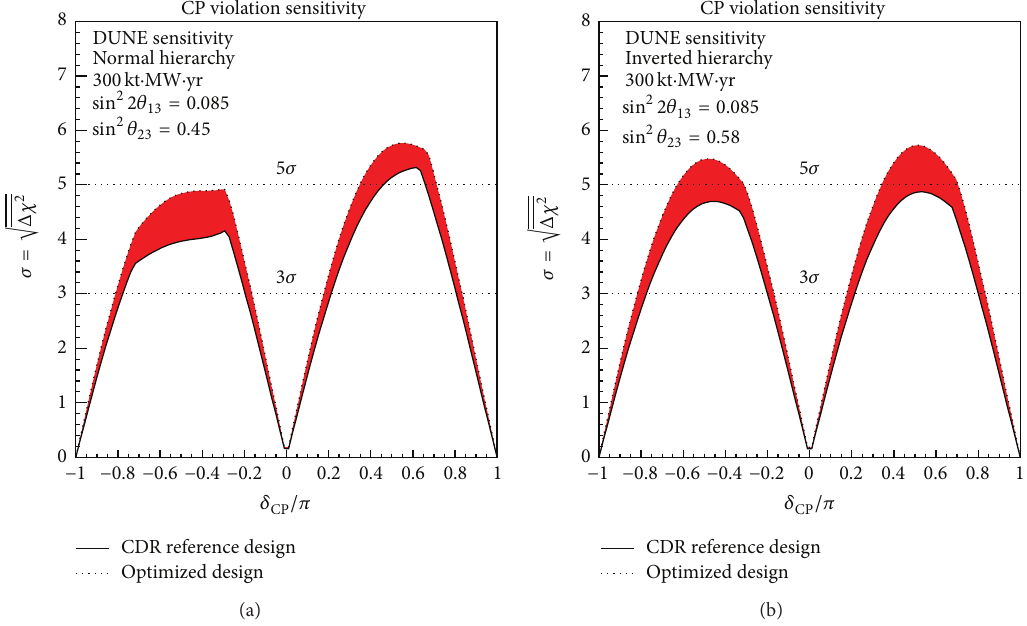
Figure 5: These figures show the sensitivity with which CP violation can be established using the LBNF beam as a function of 𝛿 (a) and IO (b). The shaded region shows the range between the CDR reference design and a possible optimized design of the